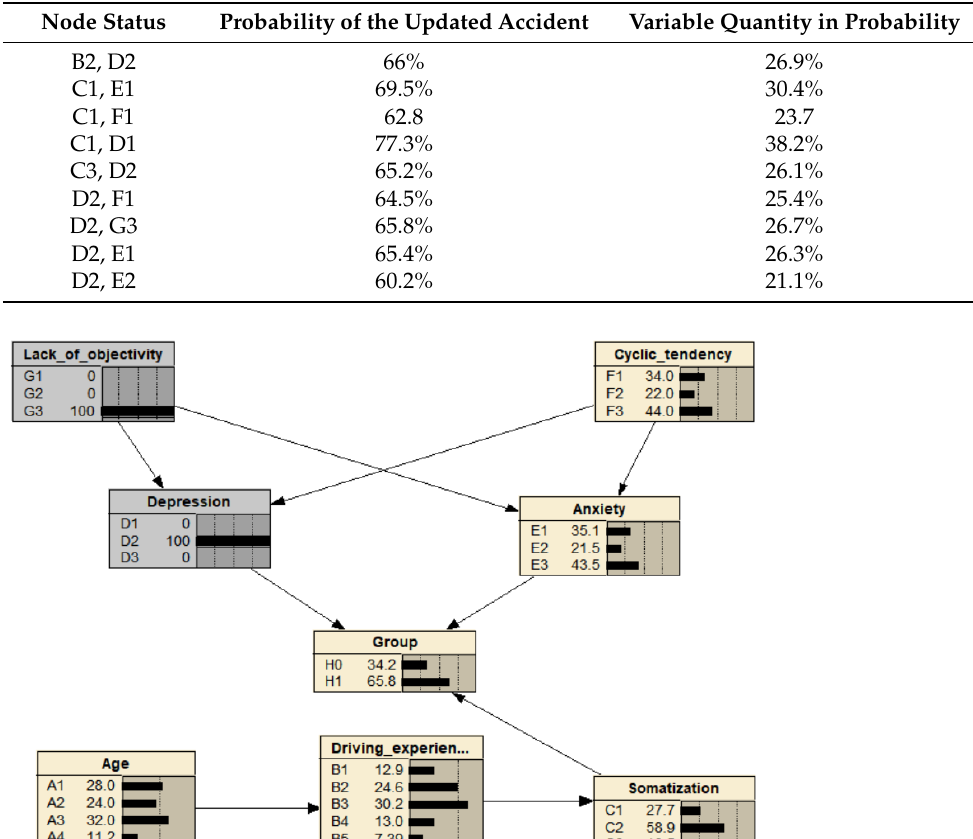
Table 6. Two-node states affecting the probabilities of accidents.